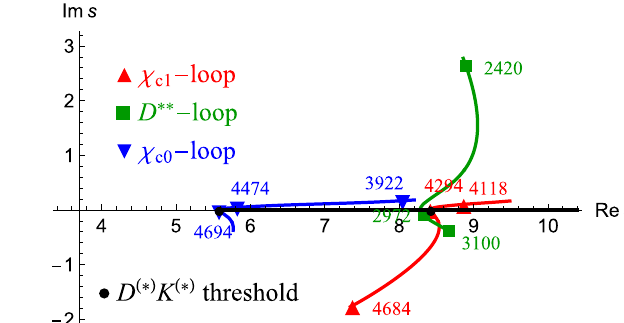
Fig. 2 The TS location of the rescattering amplitude on the complex s -plane (in unit of GeV 2 ). The thick line on the real axis represents the unitarity cut starting from the DK and D ∗ K ∗ ( D ∗ s ρ ) thresholds. The trajectories marked with up triangle, box, down triangle are obtained by varying M χ , M D ∗∗ and M χ respectively. The widths of intermediate Fig. 1 Rescattering diagrams which contribute to B 0 → ¯ D 0 D + s π − . c 1 c 0 = 50 MeV, (cid:5) = 150 MeV, and (cid:5) χ states are fixed to be (cid:5) χ D ∗∗ Kinematic conventions for the intermediate states are (a) K ∗ 0 ( q 1 , m 1 ) , c 1 50 MeV, respectively. The numbers beside the markers represent the χ ( q , m ) , D ∗ 0 ( q , m ) ,(b) D ∗+ ( q , m ) , D ∗∗ ( q , m ) , ρ − ( q , m ) , c 1 2 2 3 3 1 1 2 2 3 3 s masses of corresponding intermediate state (in unit of and (c) K 0 ( q 1 , m 1 ) , χ c 0 ( q 2 , m 2 ) , D 0 ( q 3 , m 3 ) , respectively